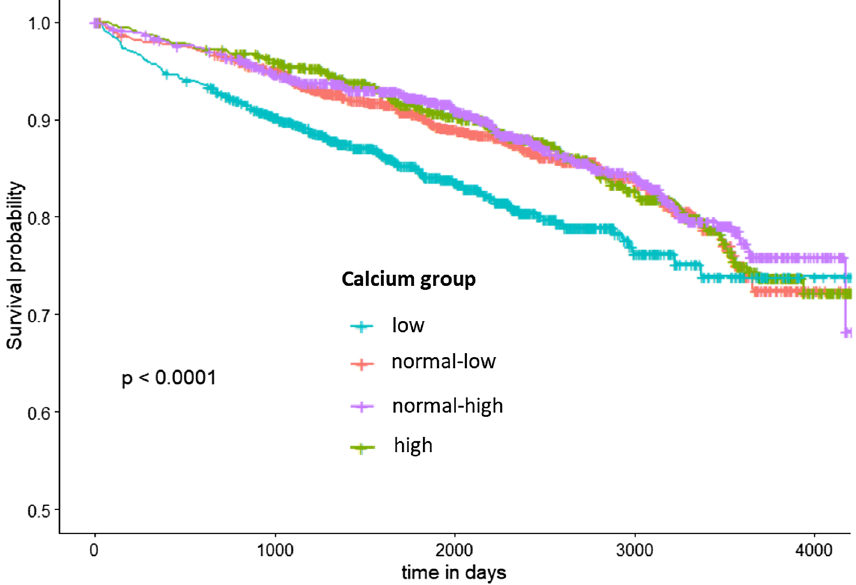
Figure 1. Kaplan–Meier Curve: long-term survival of AMI patients after 28 days by admission serum calcium concentration groups, figure generated with R version 3.6.1 9 .